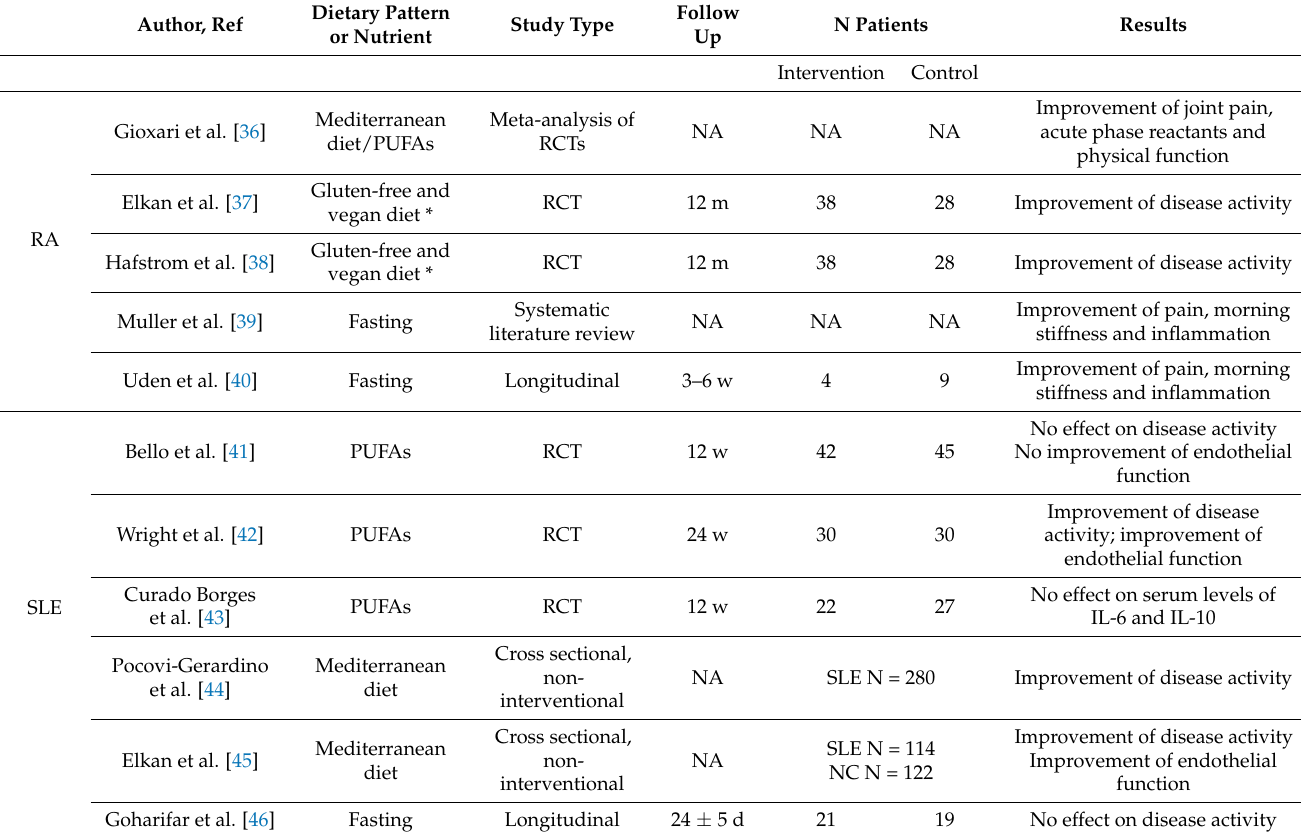
Table 2. Comparison of the effects (or lack thereof) of nutrients/dietary patterns in patients with established rheumatoid arthritis or systemic lupus